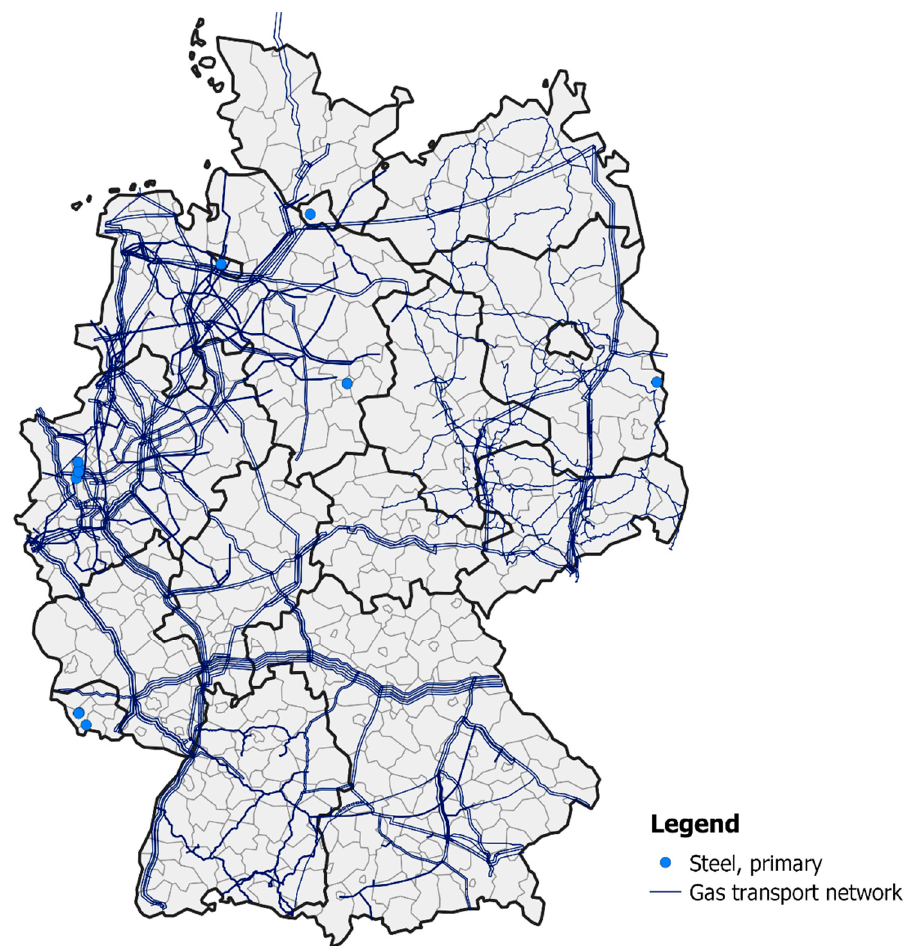
Figure 4. Steel production sites in combination with the current gas transportation network. The multiple blue lines show the redundant structure of the German gas transportation network; hence, more than one pipeline supplies the different regions. Based on [26,34] and updated from [27].